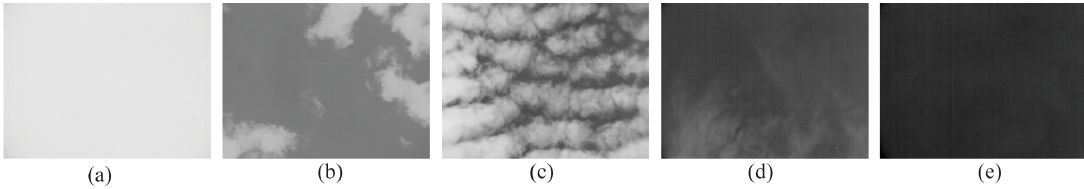
Figure 2. Cloud samples from the zenithal dataset: (a) stratiform clouds, (b) cumuliform clouds, (c) waveform clouds, (d) cirriform clouds and (e) clear sky.